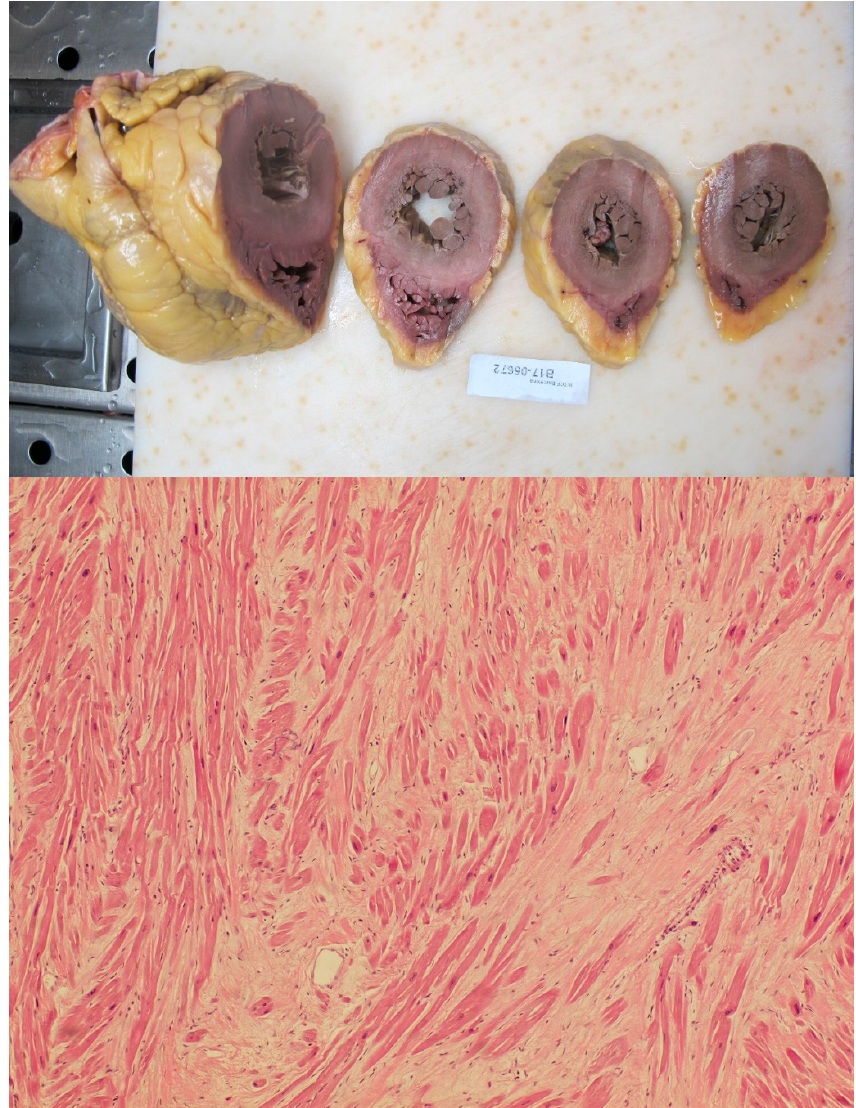
Figure 2. Macroscopic examination of the heart of a sudden death decedent showing left ventricular hypertrophy ( above ); histological analysis of the heart of another sudden death decedent at 60× showing the presence of myocardial fibrosis in the absence of disarray ( below ).